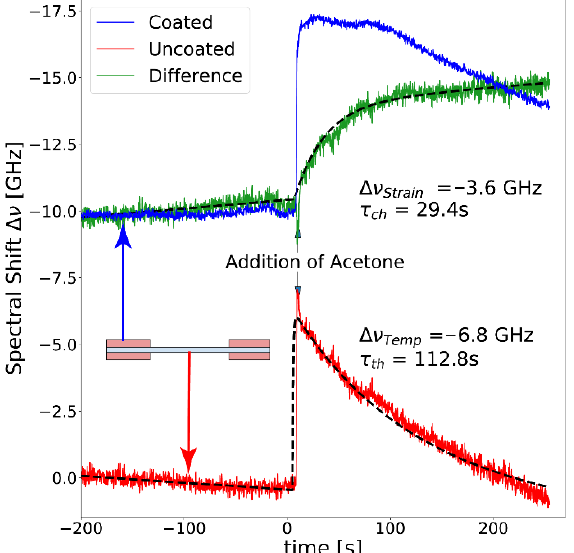
Figure 5. Rayleigh frequency shift measured from coated (blue line) and uncoated (red line) fiber sections, allowing to discriminate the temperature effects due to the water-acetone heating of mixing from swelling strain. The green line shows the temperature-compensated swelling strain built-up from the exposure of the fiber coating to a 17% molar acetone-water mixture.